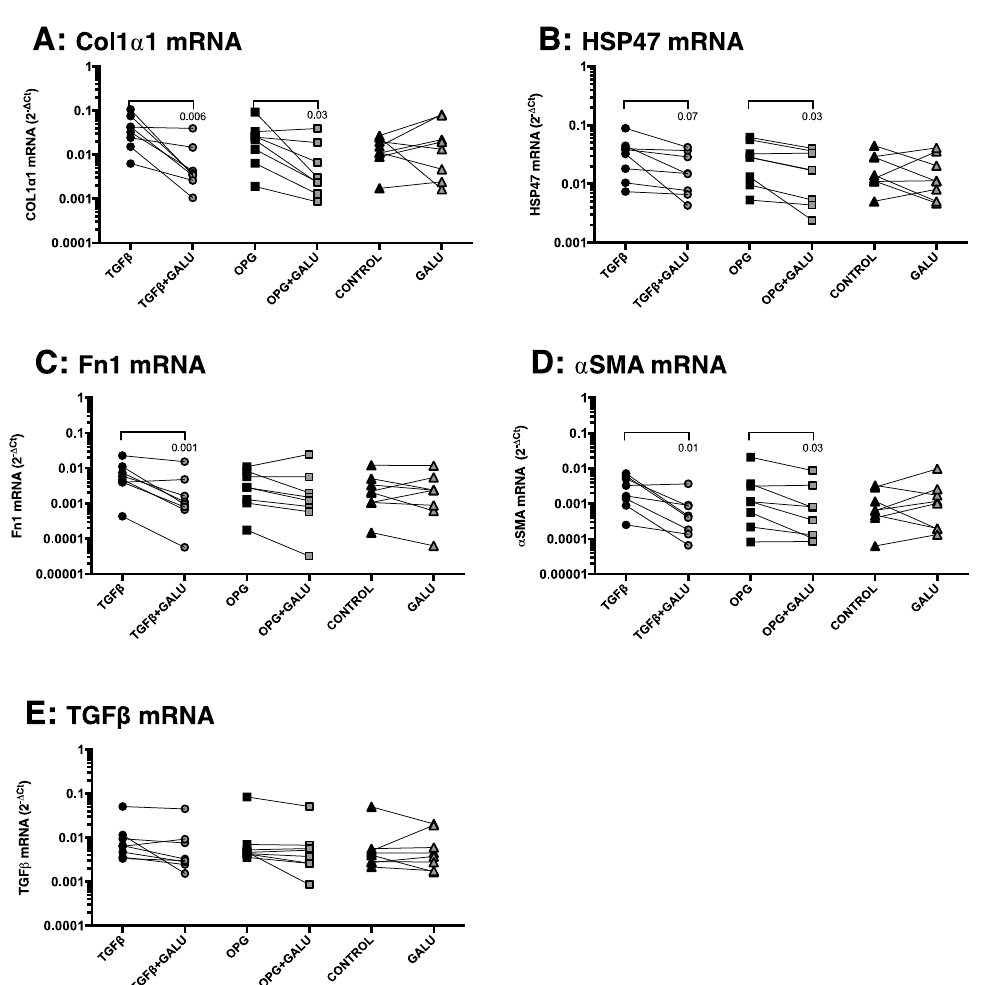
Figure 6. Inhibition of TGF β 1-signaling results in lower expression of fibrotic markers in slices treated with TGF β 1 or OPG. Inhibition of TGF β signaling by treating with galunisertib (Galu) abrogated the profibrotic effects of both TGF β 1 (positive control) and OPG. Groups with parametric data were compared using a one-way ANOVA with a Holm-Sidak’s correction for multiple testing and groups with nonparametric data with a Friedman test with a Dunn’s correction for multiple testing and p < 0.05 was considered significant.